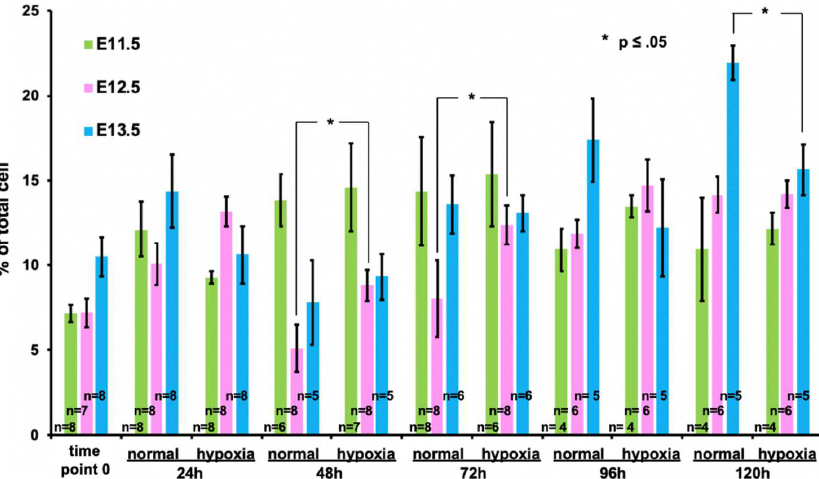
Figure 4. Percentage of Hoxb7+ kidney cells in normoxia vs. hypoxia. Hypoxic conditions exert influence on the growth of hoxb7+ cells in embryonic kidneys in in vitro culture. During the early stages of in vitro culture, hypoxia seems to increase the hoxb7+ cell population in the kidneys (time points 24 h and 48 h). At later time points, 96 h and 120 h, hypoxia seems to have the opposite effect, and hoxb7+ cells represent a smaller portion of the overall cell composition. In addition, hypoxia seems to affect kidneys isolated at E12.5 and E13.5 stronger than kidneys isolated at E11.5. Error bars represent SE.